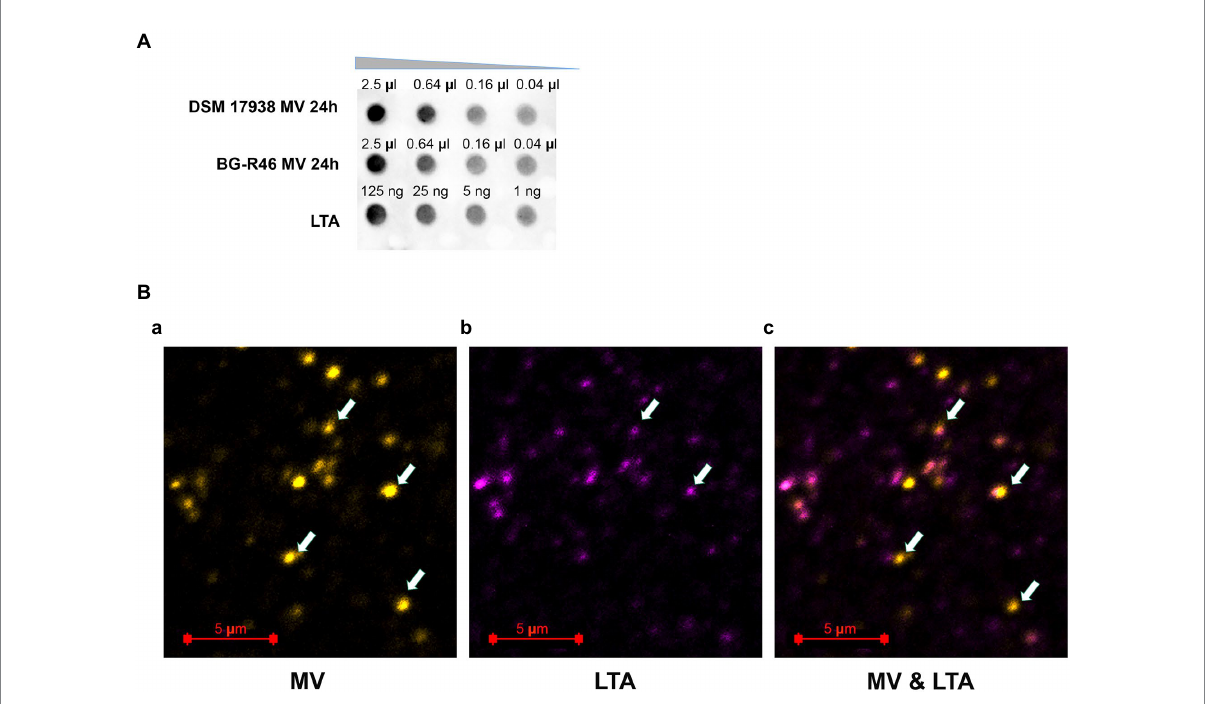
FIGURE 4 Lipoteichoic acid (LTA) presents on L. reuteri DSM 17938 and BG-R46 derived MV. (A) Dot-blot assay using the primary antibody against lipoteichoic acid (Thermo Fisher Scientific). The samples were loaded onto an activated and semi-dry PVDF membrane with different amount. The concentrations for MV from L. reuteri DSM 17938 and BG-R46 were 4.4×10 9 particles/ml. (B) Confocal immunofluorescence microscopy images of MV from L. reuteri DSM 17938. MV were stained by PKH26 (yellow color) (a) and LTA were immunolabeled by a primary antibody against